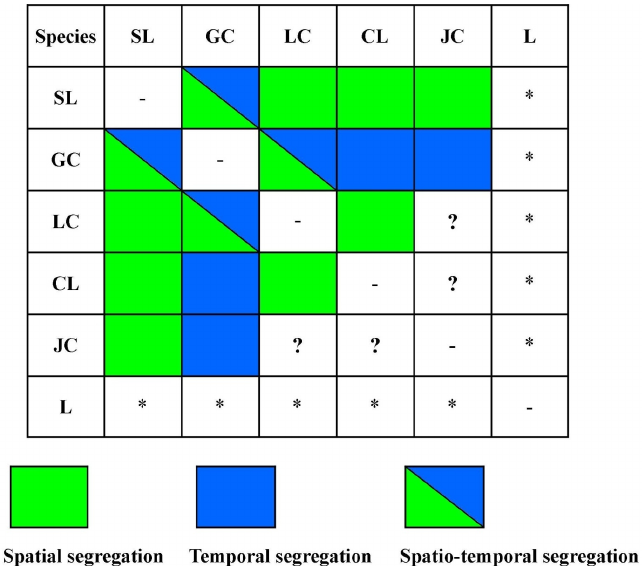
Figure 5. Block chart depicting segregation and resource partitioning among the felid species at different temporal and spatial scales. (?) suggests segregation at some different scale, (-) shows no relationship within the same species and (*) indicates insufficient data to generate meaningful inference on resource portioning between species.